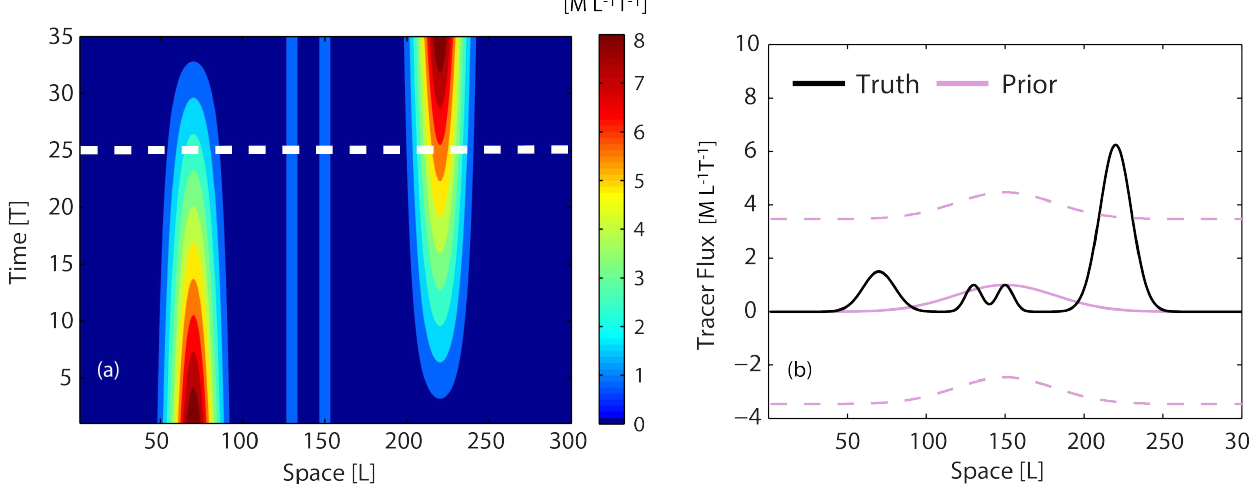
Fig. 1. (a) Spatiotemporal variability of the tracer flux. (b) True flux profile for a particular time period corresponding to the dashed white line in (a) . Also shown in (b) is the prior estimate of the tracer flux profile with its ±2 σ Q prior uncertainty (dashed